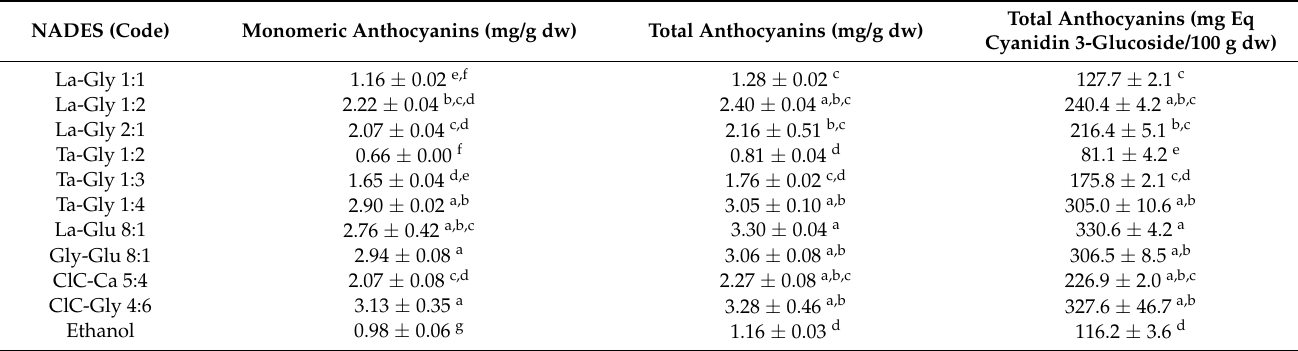
Table 1. Anthocyanin content in L. chequen (Molina) A. Gray fruit using natural deep eutectic solvents (NADES) of different